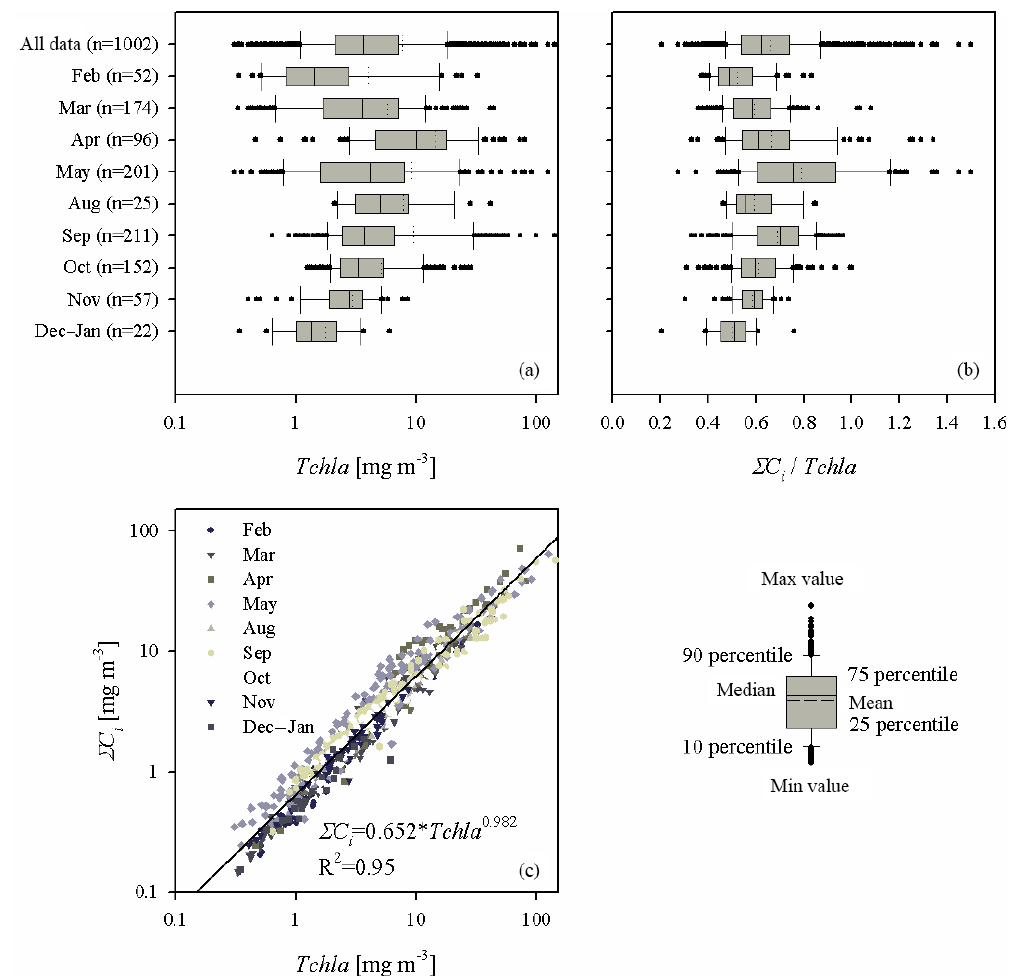
Figure 3. (a) Box plot presenting the range of variation in chlorophyll a concentration (Tchl a ) for all the data analysed and for each sampling month; (b) as (a) but showing the ratio of the sum of accessory pigments to the chlorophyll a concentration ( (cid:54)C i / Tchl a ); (c) graph illustrating the relationship between (cid:54)C i and Tchl a – the solid line represents a simple functional approximation of the relationship (the equation is given in the